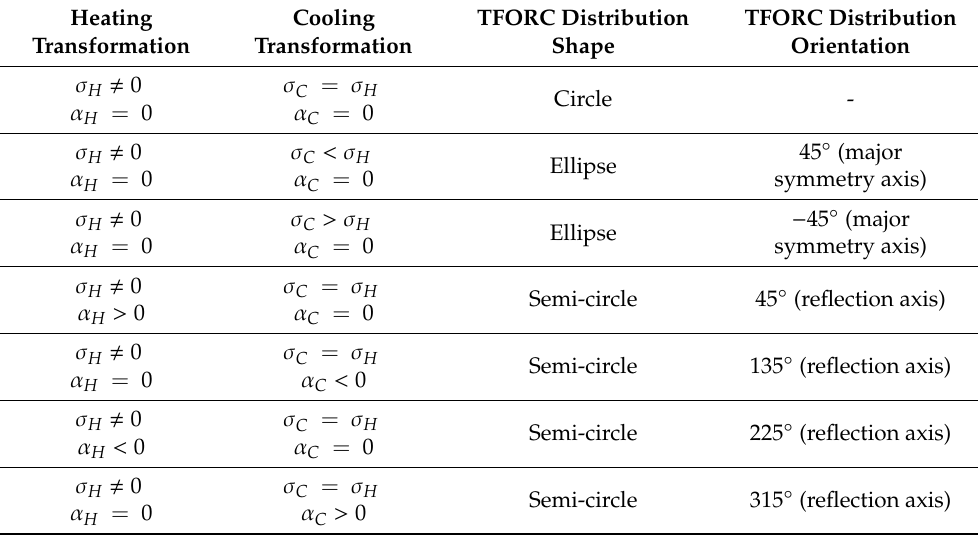
Table 1. Summary of some characteristic TFORC distributions according to the transformation